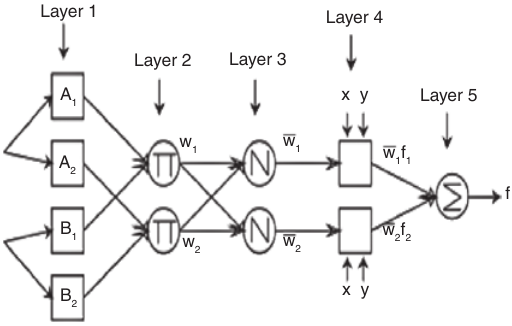
Figure 1: ANFIS Structure with Five Nodes, Two Inputs, and One Single Output